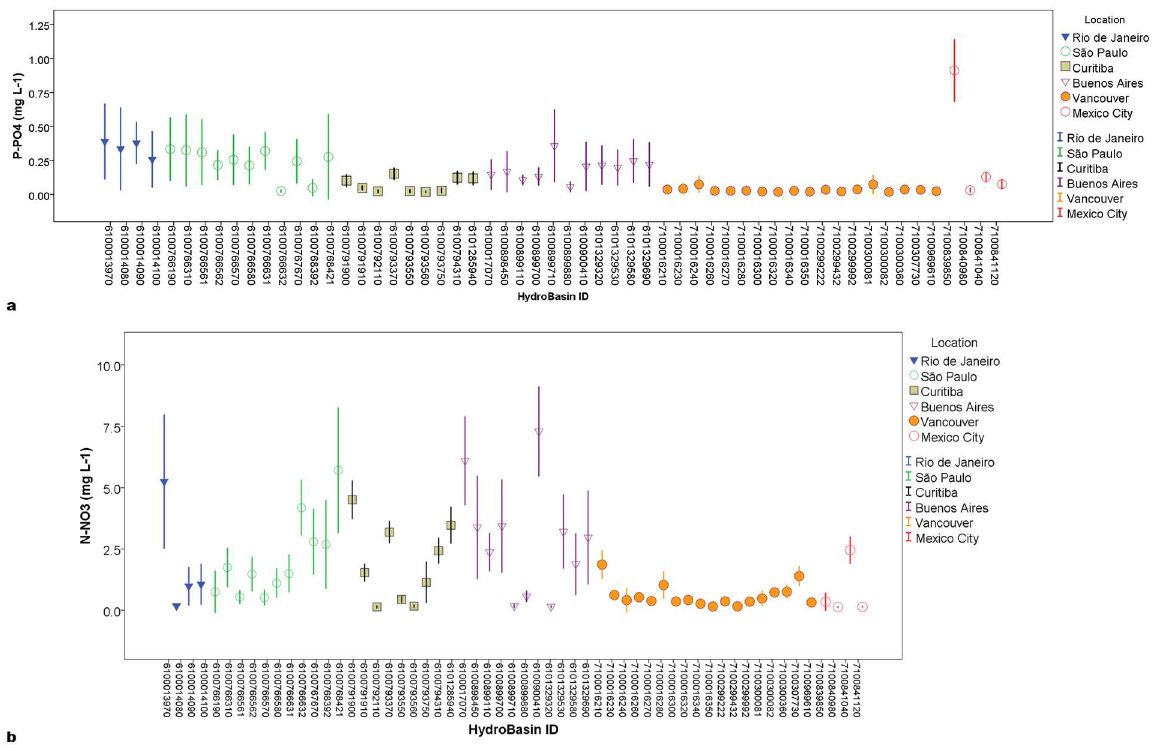
Fig 2. Averageconcentrations of phosphate (a) and nitrate (b) measuredin each sampled sub-basins (Level 10 HydroBasins on y axis) in Buenos Aires, Curitiba, Mexico City, Rio de Janeiro, S ã o Paulo and Vancouver. Bars indicate 2 standard errors